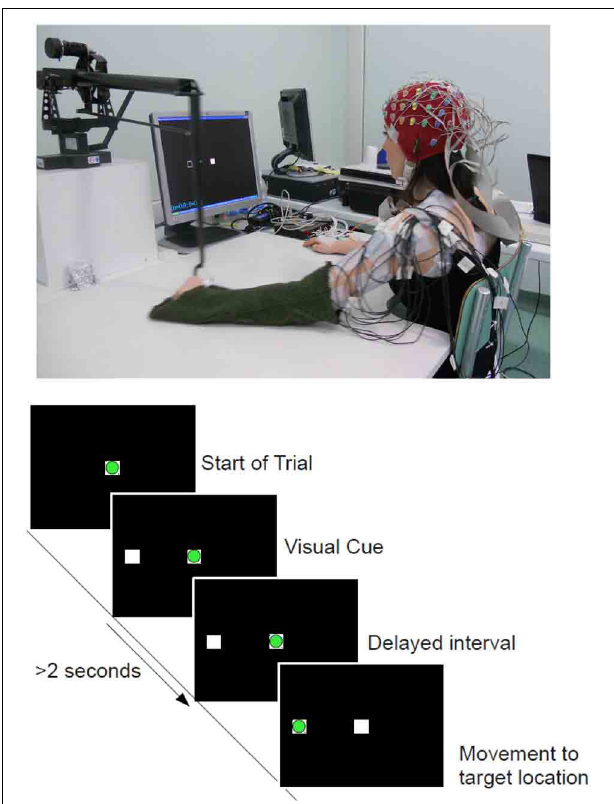
FIGURE 1 | (Top) Experimental setup and one of the able-bodied volunteer. (Bottom) Experimental Protocol: Timeline of a complete trial. The circle in green refers to the cursor being controlled with the manipulandum and the white squares corresponds to the home (Center) and target (Left) locations. Movement onset is defined as the time when the green cursor exits the center